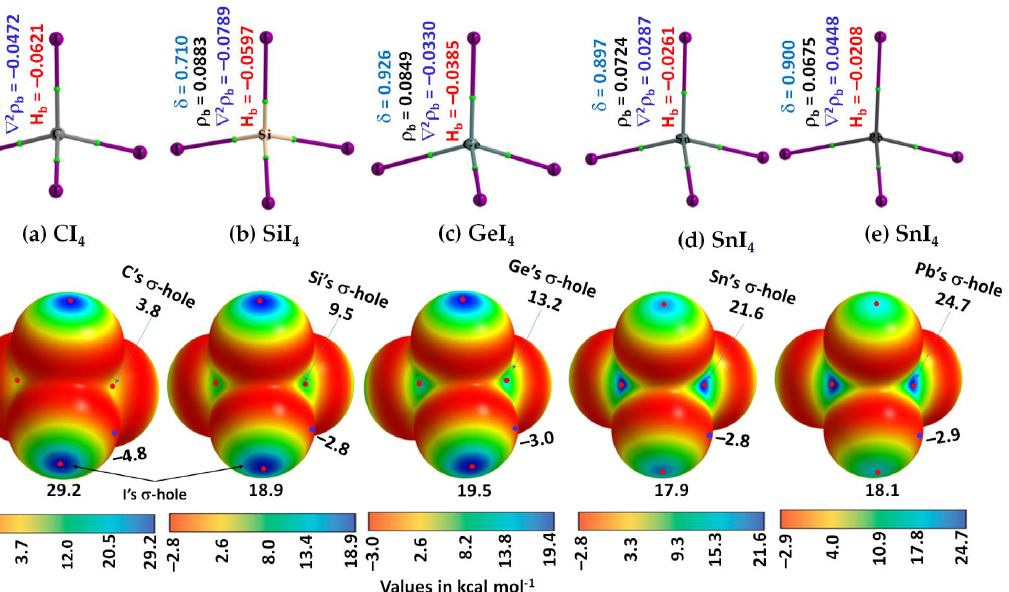
Figure 2. ( Top ) [ ω B97X-D/def2-QZVPPD] level QTAIM-based molecular graphs of isolated TtI 4 (Tt = C, Si, Ge, Sn, and Pb), showing bond paths (solid lines in atom color) and bond critical points (tiny spheres in green) between bonded atomic basins (large spheres). The charge density( ρ b ), the Laplacian of the charge density ( ∇ 2 ρ b ), the total energy density (H b ), and the delocalization index ( δ ) values are shown in black, blue, red, and faint-blue fonts (in a.u.), respectively. ( Bottom ) The 0.001 a.u. (electrons bohr − 3 ) isoelectron density mapped potential on the electrostatic surfaces of the corresponding monomers, including ( a ) CI 4 , ( b ) SiI 4 , ( c ) GeI 4 , ( d ) SnI 4 , and ( e ) PbI 4 . The strength of Tt’s and I’s σ -holes is shown in each case; filled tiny blue and red circles represent V S,min and V S,max , respectively; V S,min and V S,max values are in kcal mol − 1